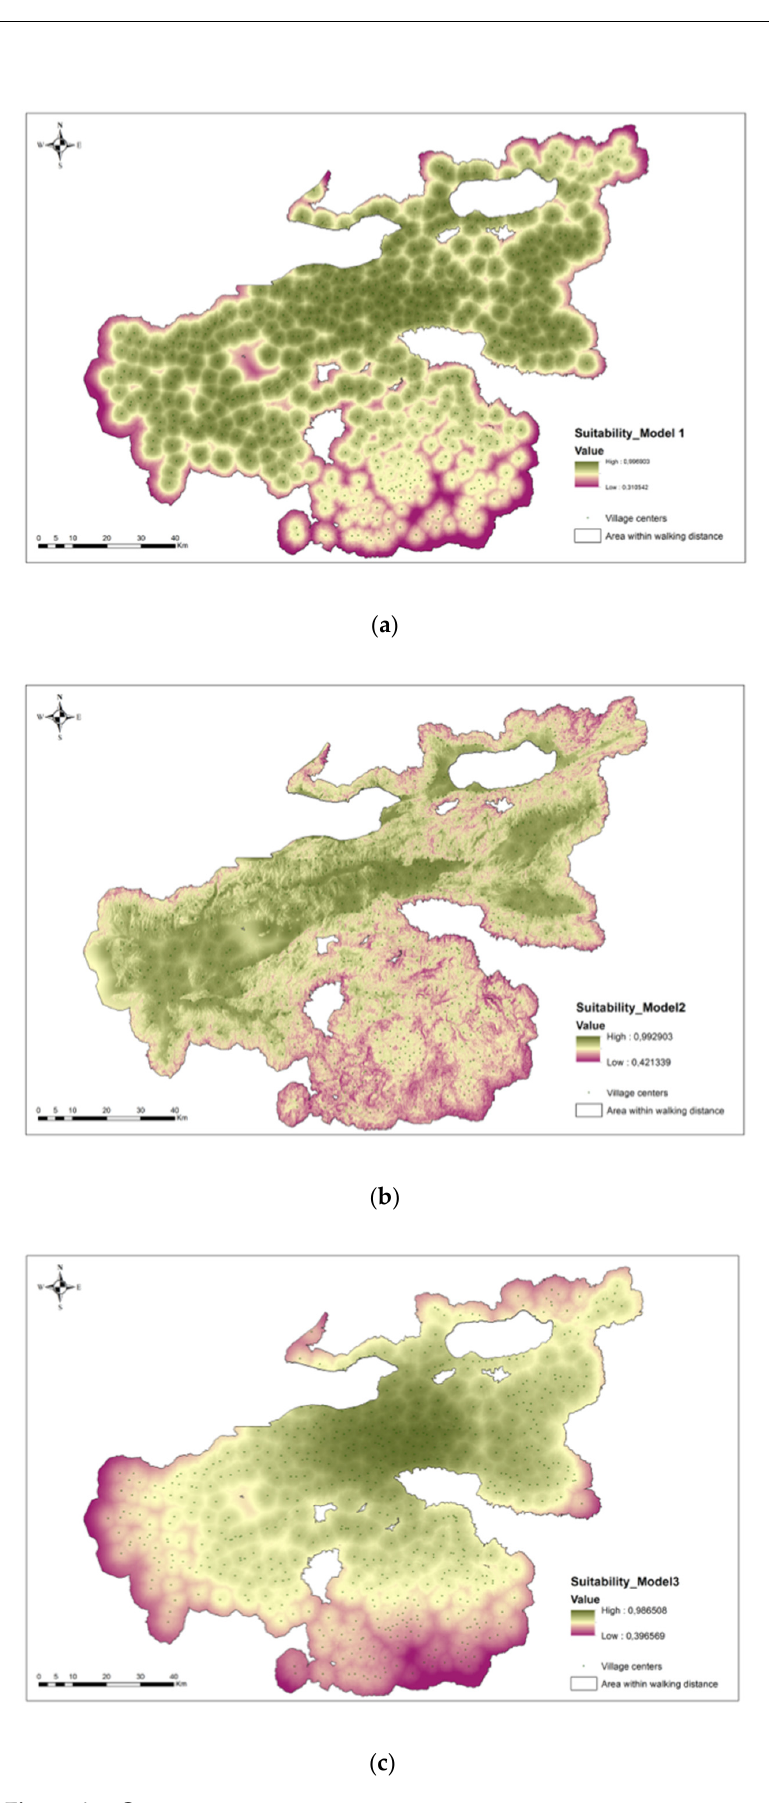
( d ) Figure A2. Residential suitability maps for different scenarios ( a ) Model1, ( b ) Model2, ( c ) Model3, ( d ) Model4. Figure A3. Distribution of errors for each OLS Model.